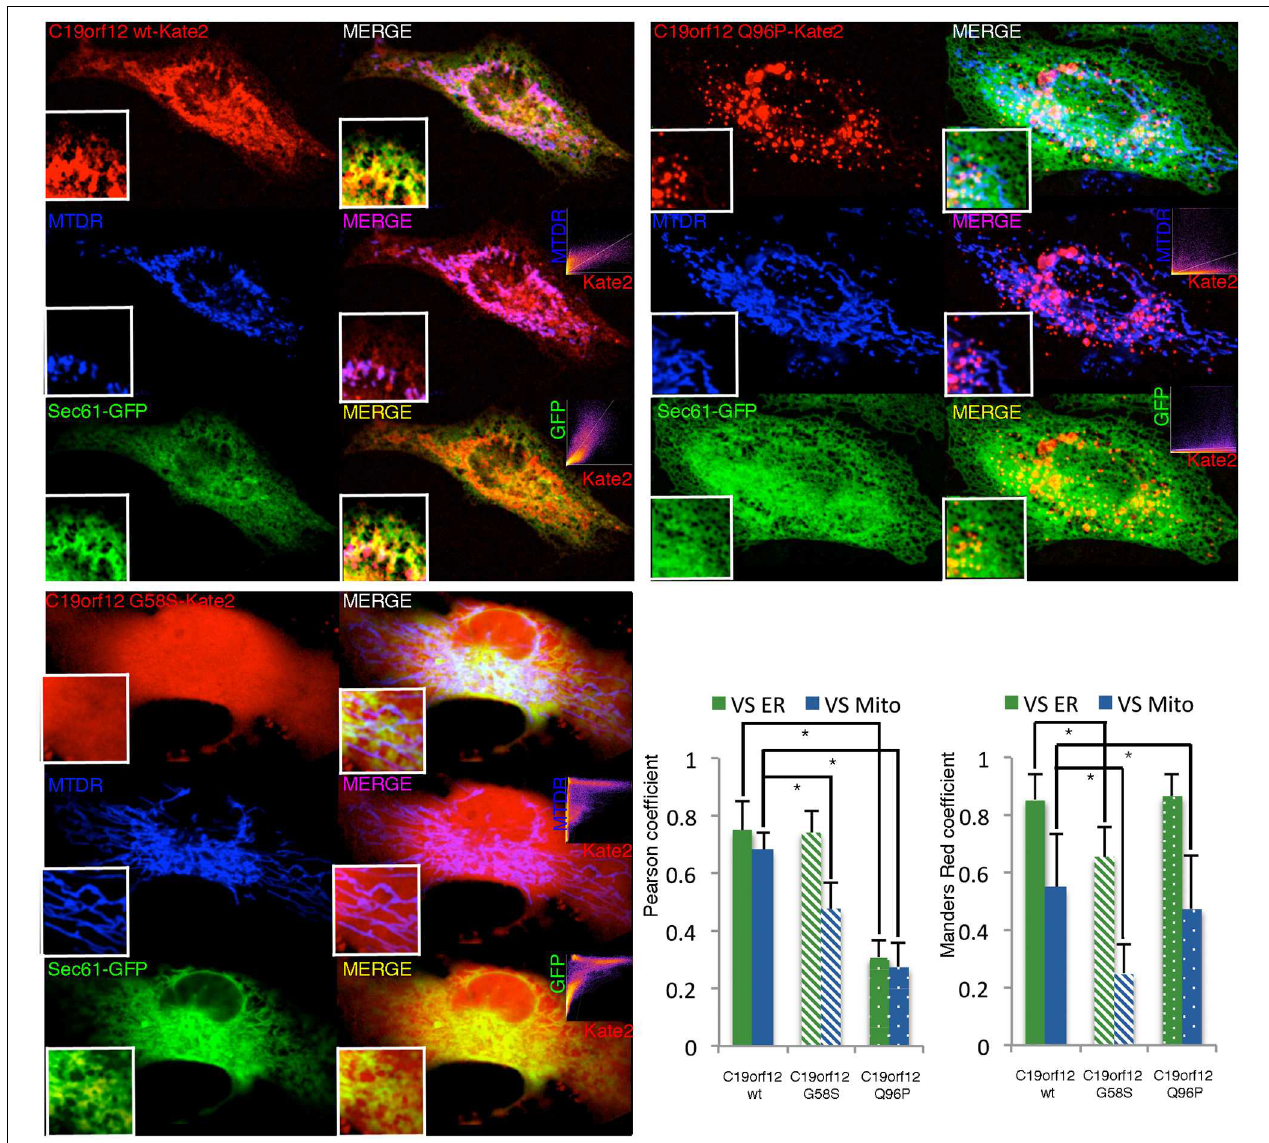
each merging the relative colocalization scatterplot is inserted as inset on bottom right corner. Analysis of colocalization is represented by Pearson’s coefficient (indicating the correlation between mKate2 and mitochondria or ER signals) and by the Mander’s Red coefficient (representing the proportion of mKate2 signal overlapping with mitochondria or ER). Bars: S.E.M., * p < 0 . 05